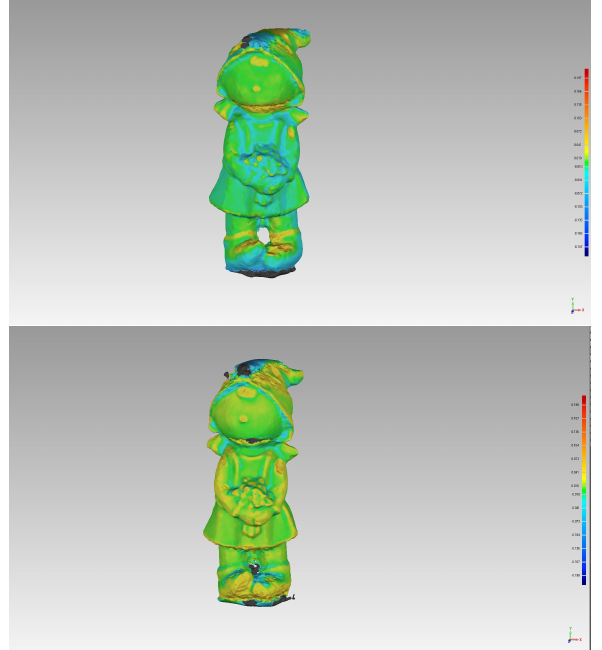
Figure 6. Distances in mm to the ground-truth 3D model for the 3D model reconstructed using images captured by a human operator (top) and the 3D model reconstructed using images captured by an agent trained using our RL3D framework (bottom).